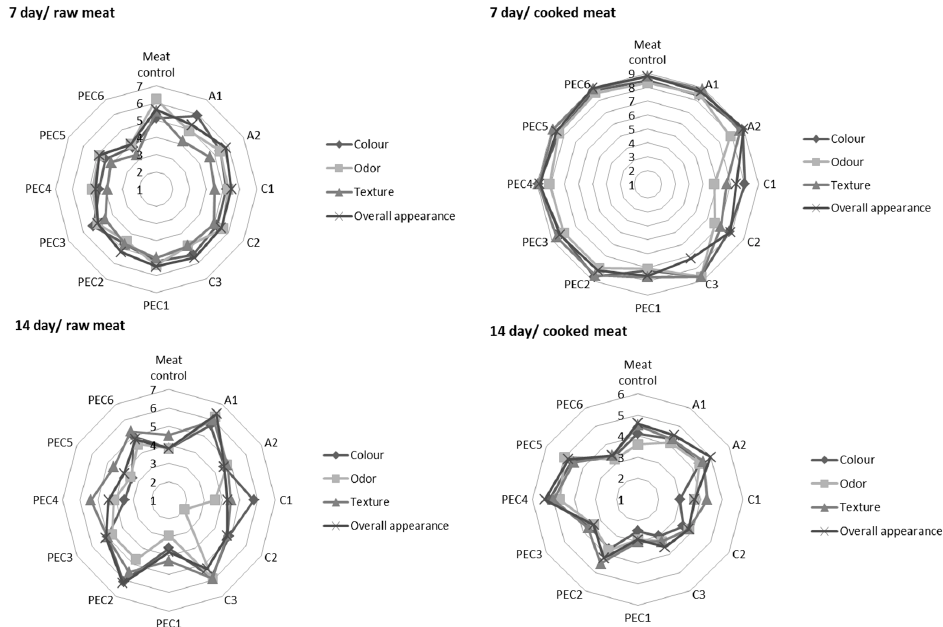
Figure 3. Sensory acceptance of raw (left column) and cooked (right column) pork meat uncovered/covered with sodium alginate (A1, A2), chitosan (C1, C2, C3), and sodium alginate-chitosan polyelectrolyte complex (PEC1–PEC6) during 0, 7, and 14 days of chill storage. A nine point hedonic scale was expressed as numbers 1–9 with boundary indications: ‘I do not like very much’ (1), ‘I neither like nor dislike’ (5), and ‘I like very much’ (9); n = 3.